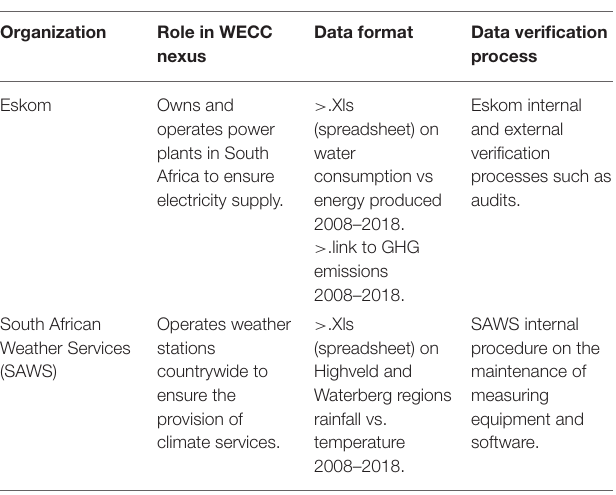
TABLE 1 | Sources of